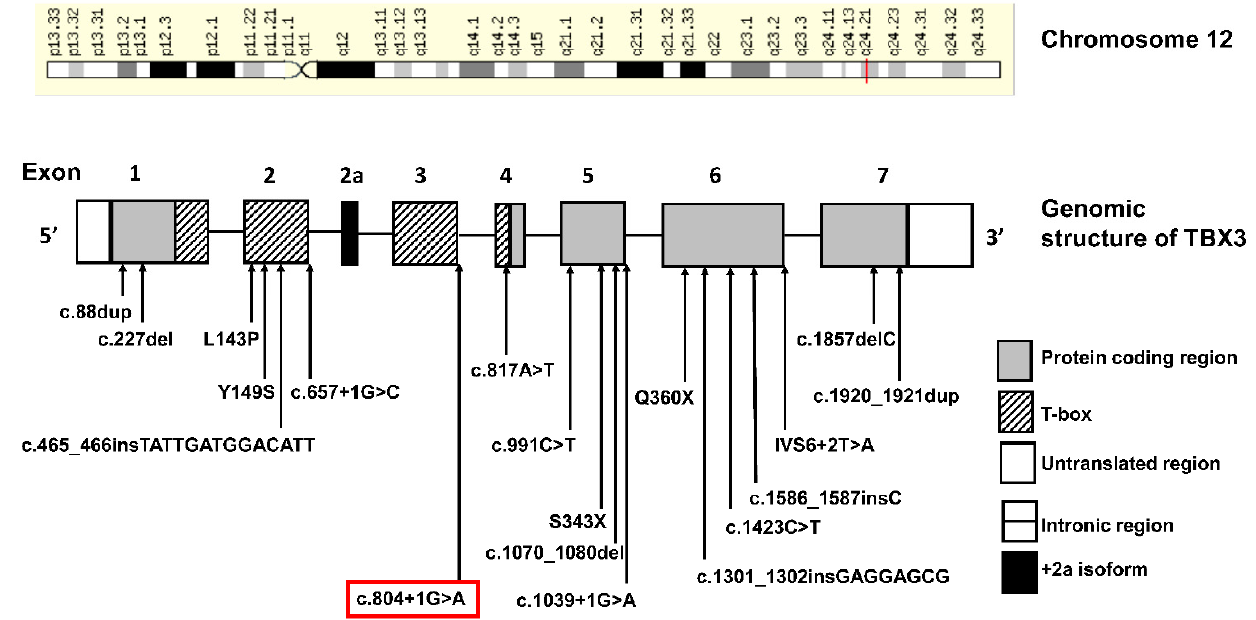
Figure 2. Chromosomal position and genomic structure of the T-Box 3 ( TBX3 ) gene and known disease-causing variants which have been published in the literature. Our proband’s variant is highlighted in the red box.